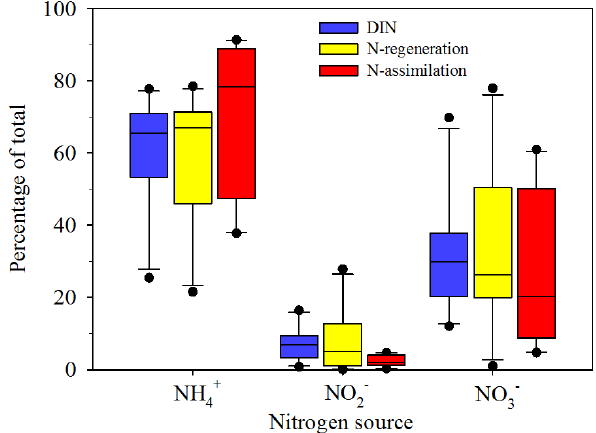
Figure 6. Ratio between dissolved inorganic nitrogen (DIN) avail- ) , inorganic nitrogen regeneration rate ability (NH + :NO − :NO − 4 2 3 (NH + regeneration:NH + oxidation:NO − oxidation) and inor- 4 4 2 ganic nitrogen assimilation rate (NH + assimilation:NO − assimi- 4 2 lation:NO − assimilation) derived from all data measured at obser- 3 vational